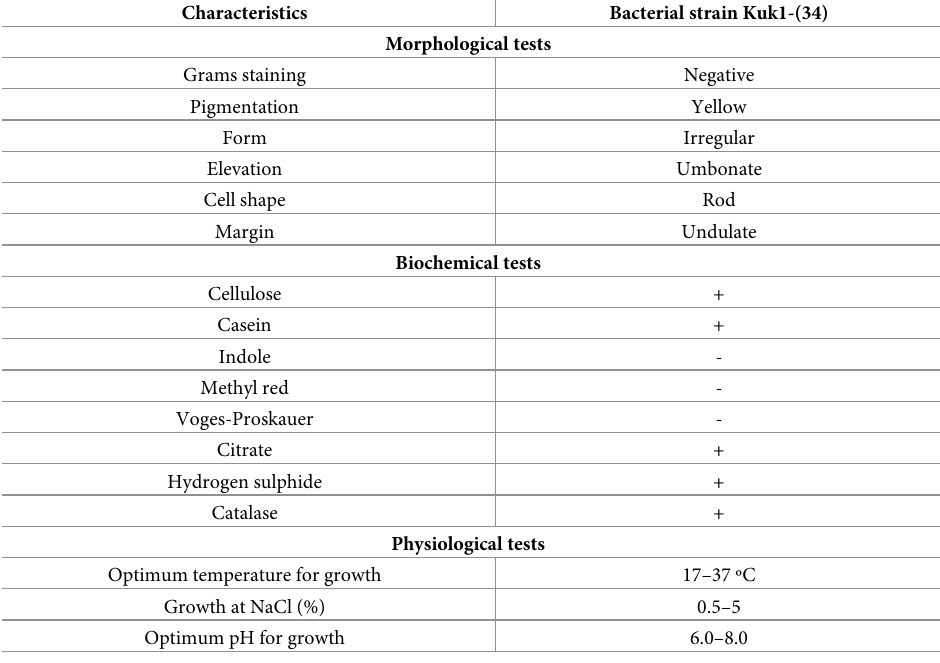
Table 3. Morphological, biochemical and physiological characteristics of the bacterial strain